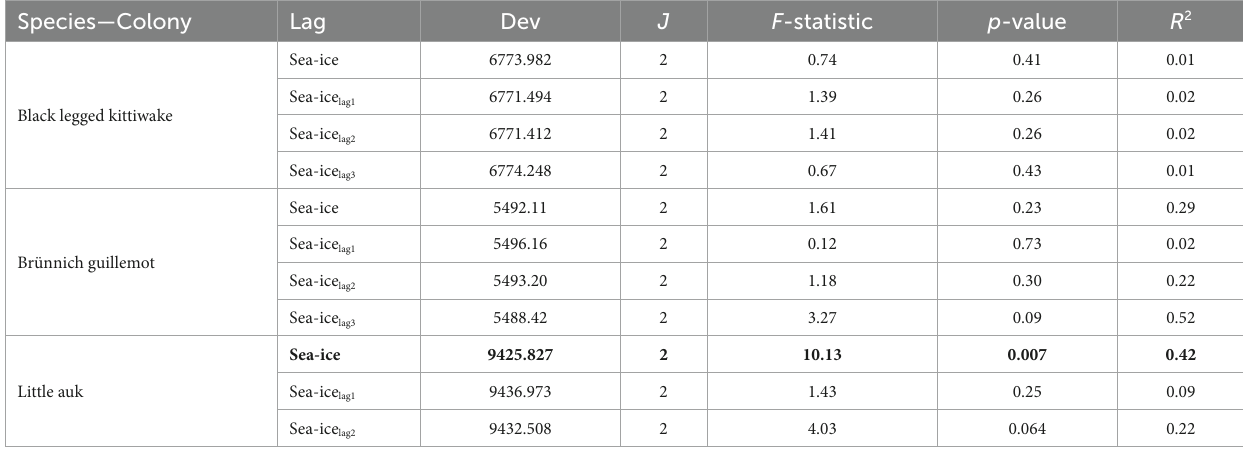
TABLE 1 Results of the ANODEV from the models testing for the effects of maximum sea-ice concentration with and without time-lag on survival probability of Brünnich guillemots, little auk, and black legged kittiwake breeding in west Svalbard, over the study periods. Species—Colony Lag Dev J F -statistic p -value